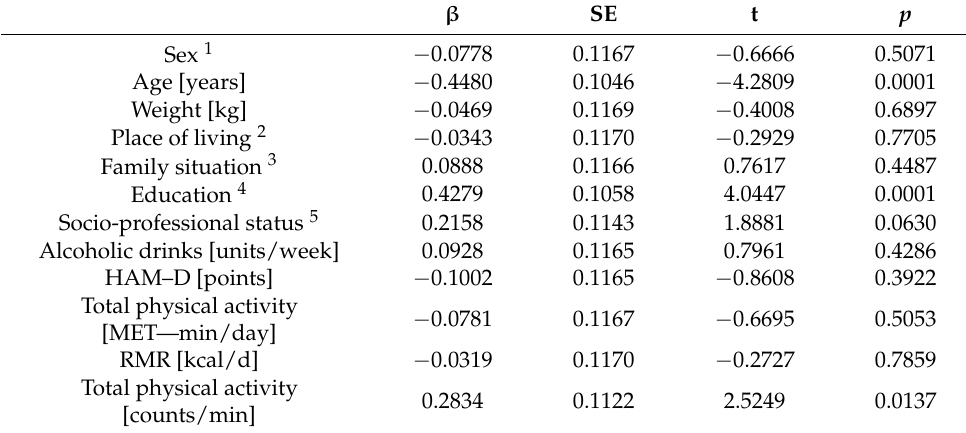
Table 12. Univariate linear regression analysis assessing the relationship between MoCA points and selected variables in the total study population ( n = 75).